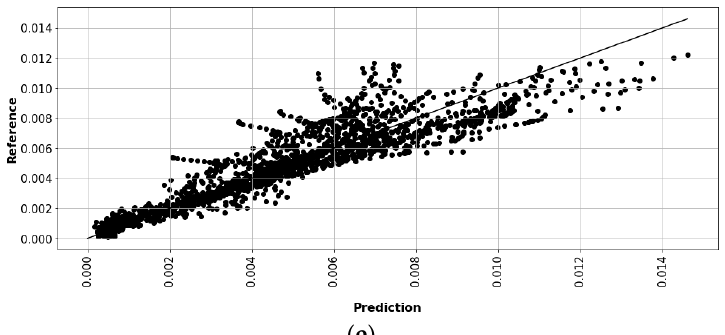
Figure 17. SD results of the TP and VP for Tahara City Hall building: ( a ) Convergence curve—loss in the TP; ( b ) confusion matrix—usability of the building by VP; ( c ) confusion matrix—total damage condition by VP; ( d ) confusion matrix—storey damage condition by VP; ( e ) total comparison of SD.